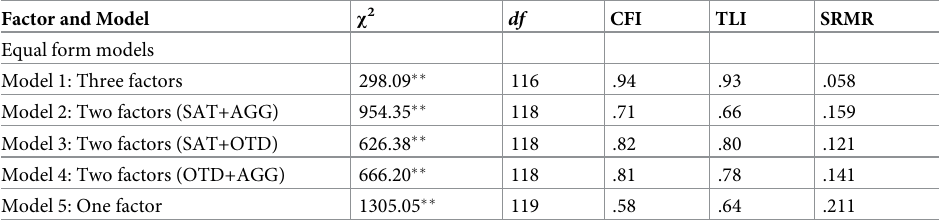
of the other possible two-factor and one-factor models show a substantial loss of fit relative to the three-factor model (e.g., CFI and TLI < .90 and SRMR > .08 in all these models). A com- parison between the models’ chi-squared scores revealed that the three-factor model provides a better fit than all other models (p < .01). Next, we added the latent interactions to the null model (OTD X language accessibility; OTD X cultural affiliation; and the three-way interaction). This model fit the data significantly better than the model without the latent interaction terms (-2 log-likelihood = 5456.40); ( Δ -2 log-likelihood = 7.86; χ 2 = 7.86, p < .05). See Table 3 and Fig 1. (3) The results revealed a significant three-way interaction between care receivers’ OTD, lan- guage accessibility, and cultural affiliation, influencing satisfaction (B = 1.39, p < .05). To